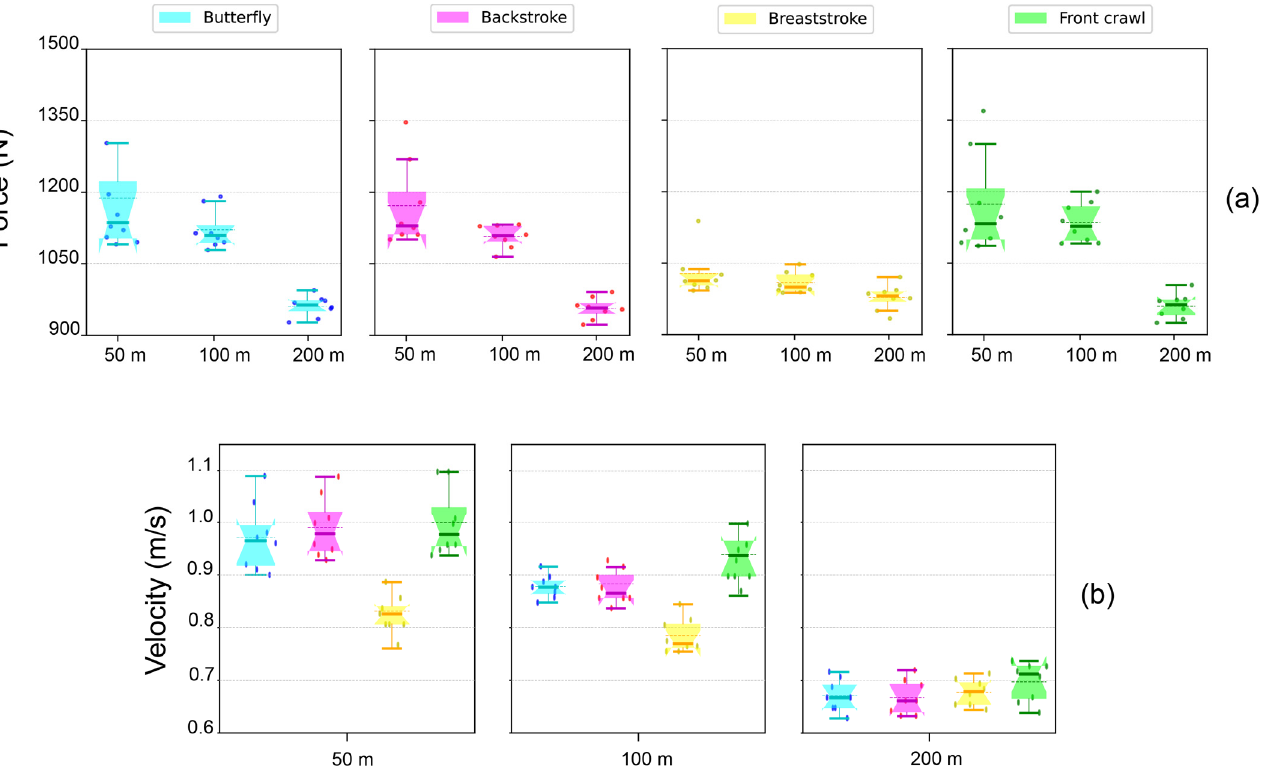
Figure 2. Scatter box plot showing the maximum force (N; panel ( a )) and velocity (m/s; panel ( b )) exerted in the single pull-up test, before the swimming competition. ( a ) Within all four strokes, a trend emerged where the sprinters (both 50 m and 100 m) could exert significantly higher forces compared to the medium-distance swimmers. Although it remained statistically significant, this trend was less evident regarding the breaststroke swimmers. ( b ) The 50 m and 100 m breaststroke swimmers presented significantly lower levels of velocity in the single pull-up test compared to the swimmers of other strokes competing in the same distance. However, this was not the case with the group of 200 m swimmers, where there were no significant differences among the groups.